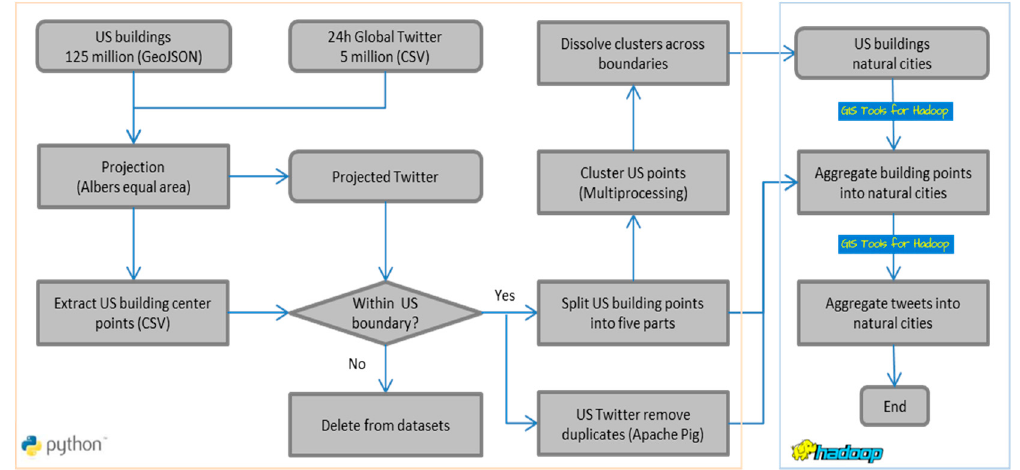
Figure 1. Data processing flow map.